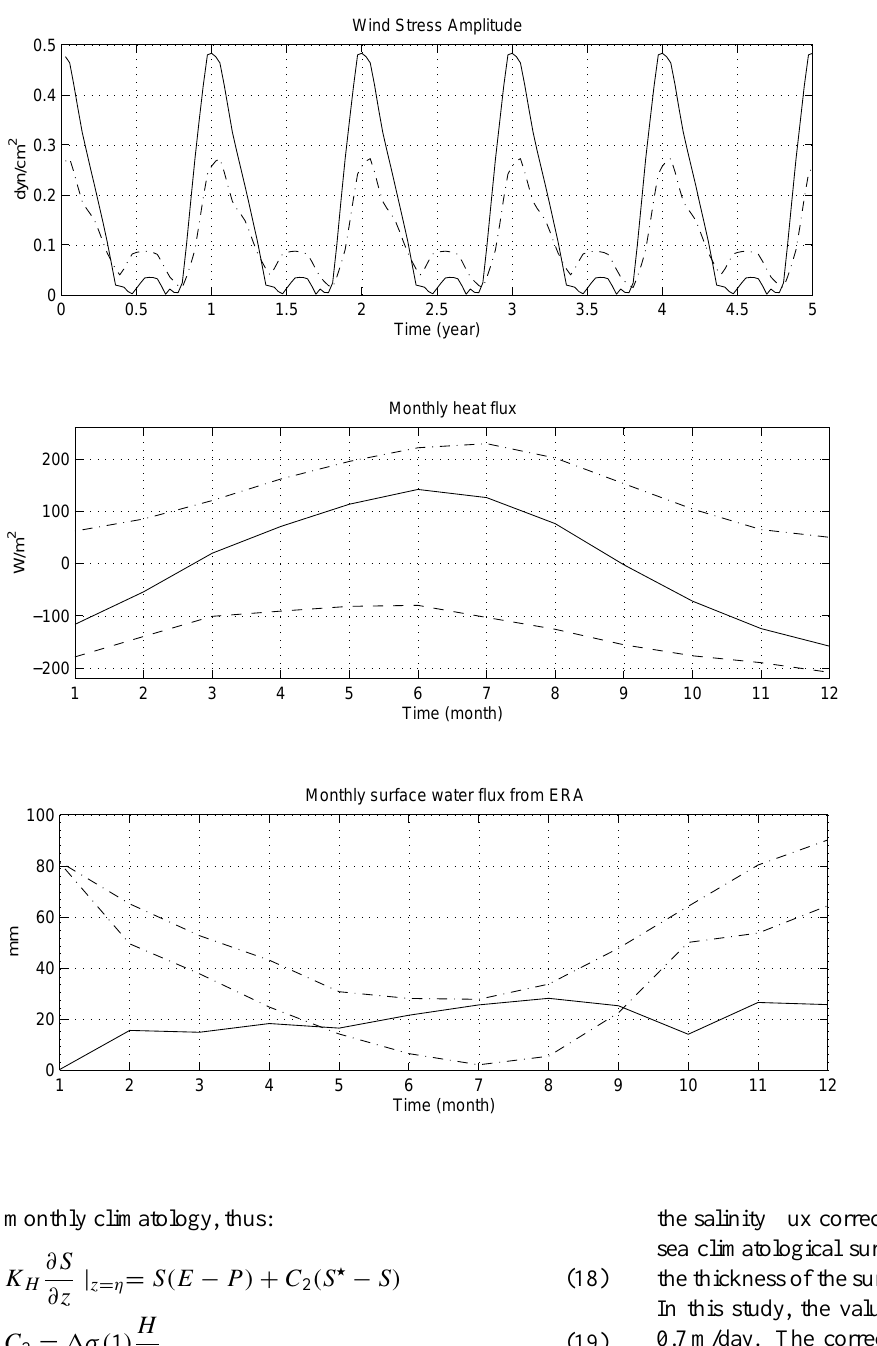
Fig. 6. Annual cycle of the total fresh- water flux (E-P) (solid line), evapora- tion (dash-dot line) and precipitation (dashed line) from the ERA data set. Units are